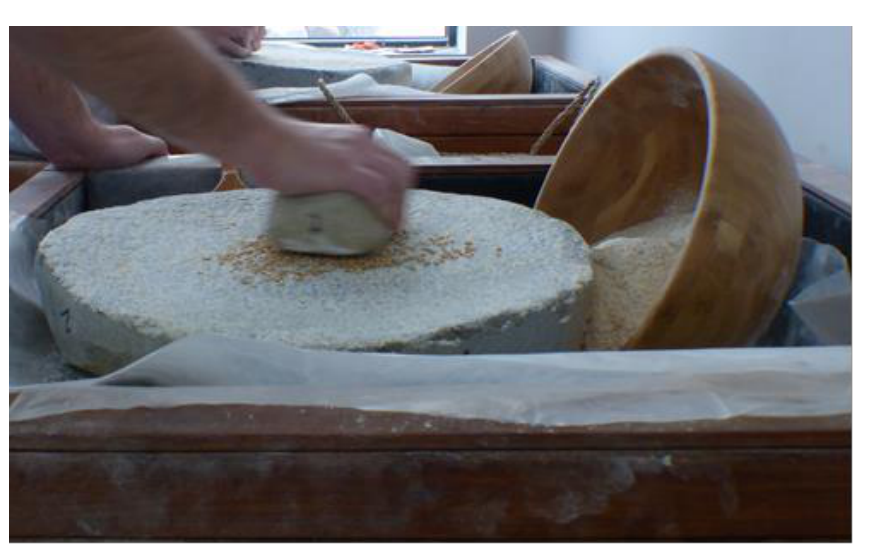
Figure 1. Grinding cereals for experimental foods in the context of the European Research Council (ERC) PlantCult project.